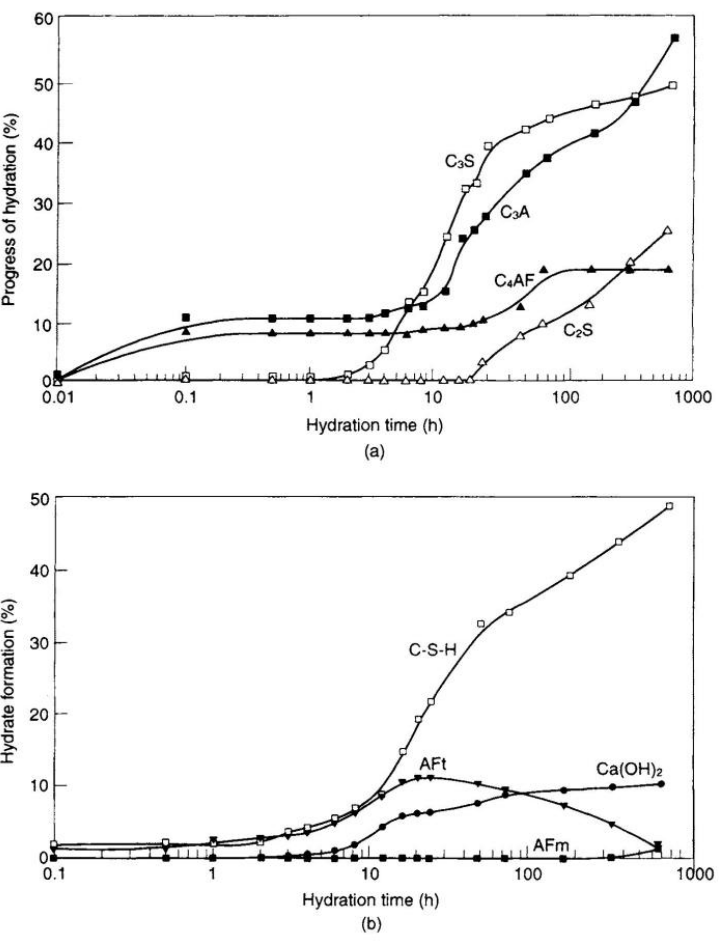
Figure 3. Graph reporting the progress of hydration as a function of the hydration time for the principal components of an OPC: consumption of clinker phases (( a ), top), and formation of hydrate phases (( b ), bottom). Reprinted with permission from [1].